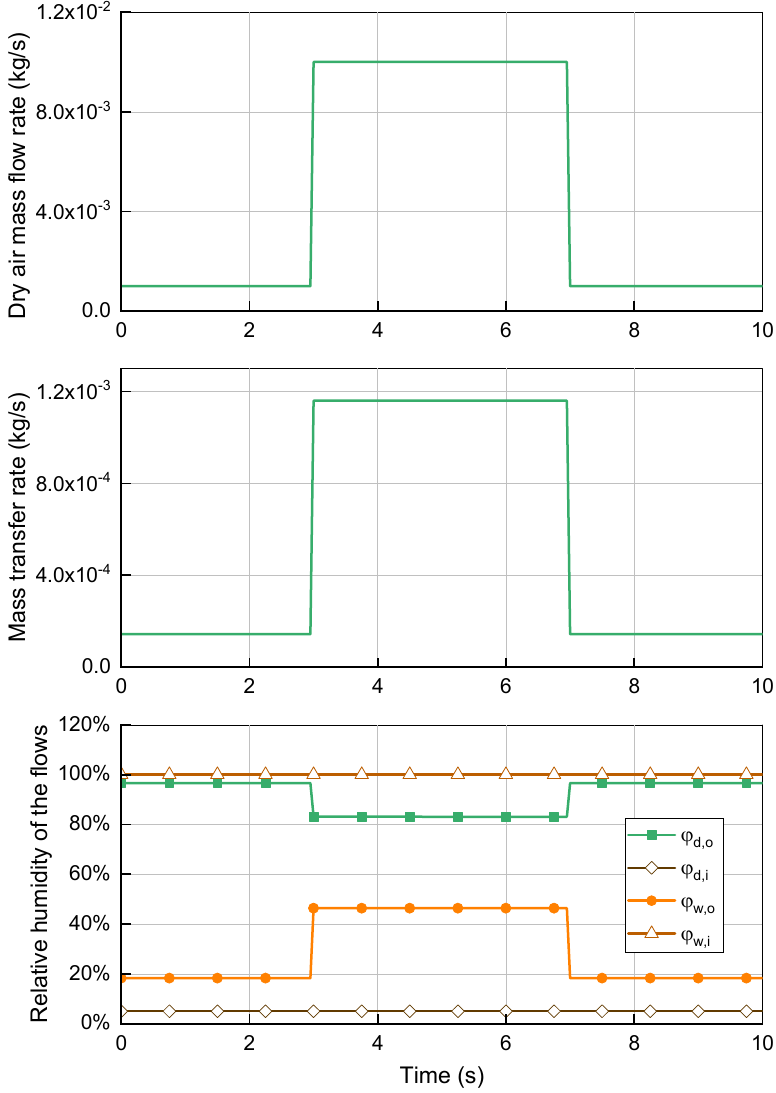
Figure 8. Response of the humidifier to stepwise changes in the dry air flow.